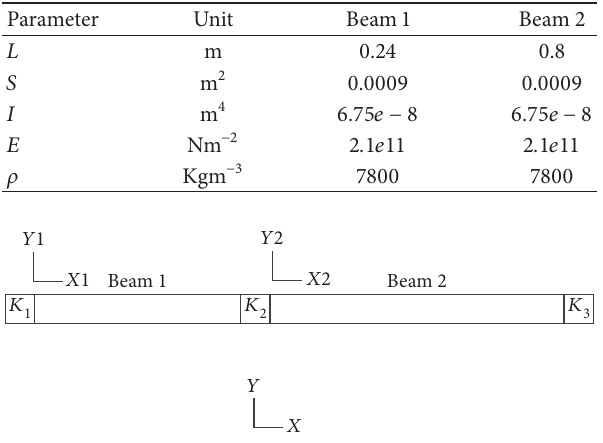
Figure 2: Coupling beam structure with 0 ∘